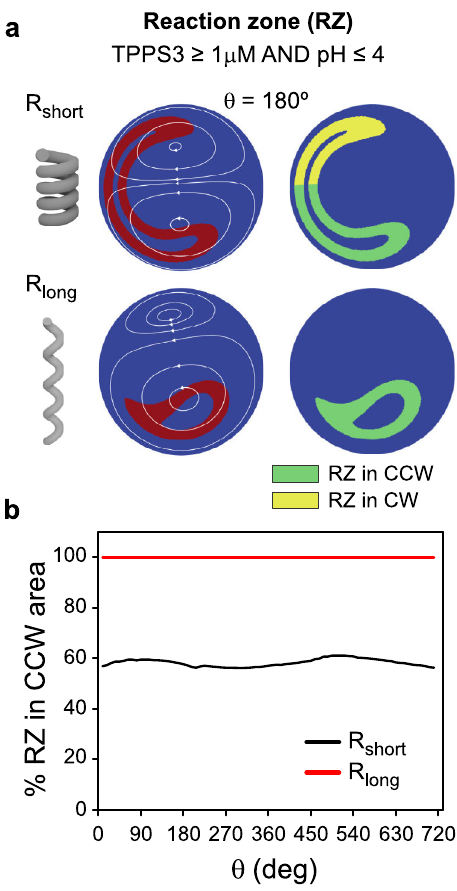
Fig. 3 Evolution of the reaction zone along the helical channels. a De fi nition of the reaction zone (RZ) and representation of the RZ calculated at the cross-section corresponding to θ = 180° for R short and R long devices (red colour in left panels). In the right panels the RZ is sorted in subregions depending on whether it is located in the CCW or CW vortex area (green and yellow colours, respectively). b Evolution of the fraction of the RZ exposed to the CCW vortex while the fl uid moves downstream along the helix, in the R short and R long devices (two helical turns are reported for clarity, but analogous results were obtained for four